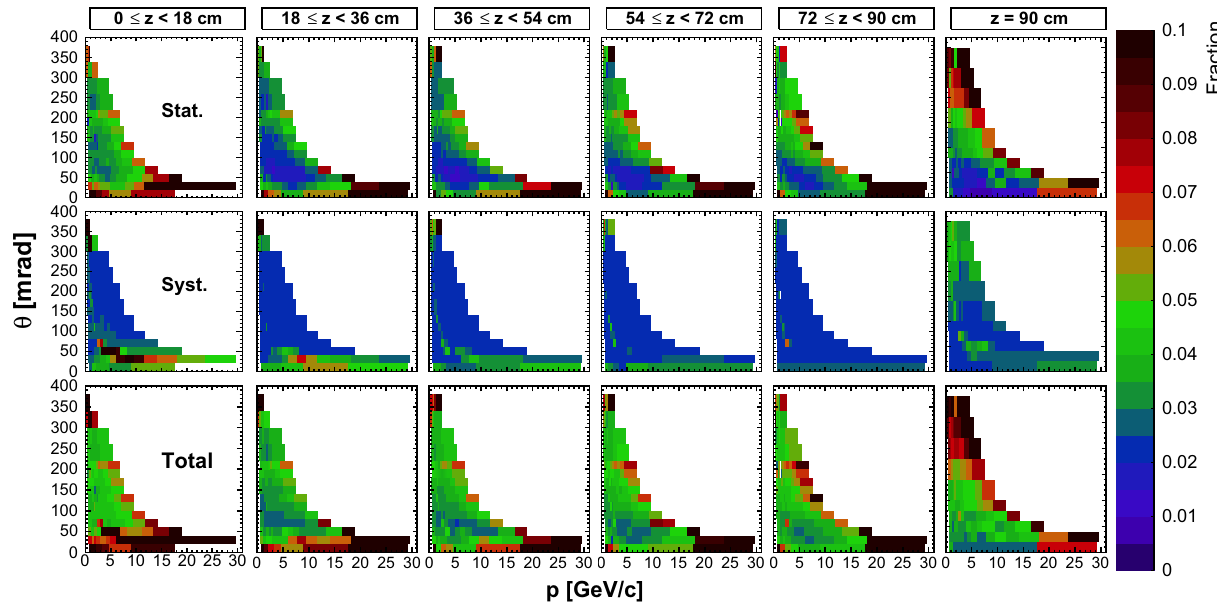
Fig. 17 Uncertainties on π + yields shown as a function of p and θ : statistical uncertainties (top row), total systematic uncertainties (middle row) and total uncertainties (bottom row). Each column corresponds to a different longitudinal